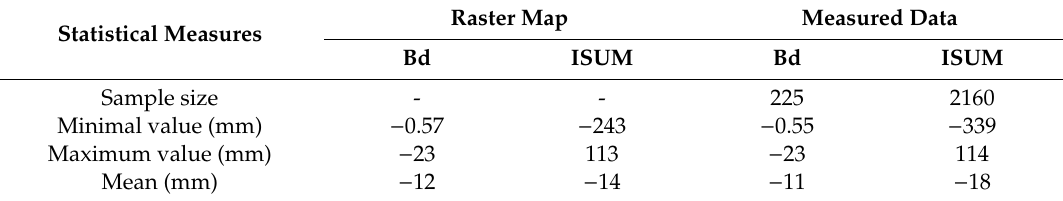
Table 4. Descriptive statistics of soil lowering data and maps obtained using ISUM and Bd. Raster Statistical Measures